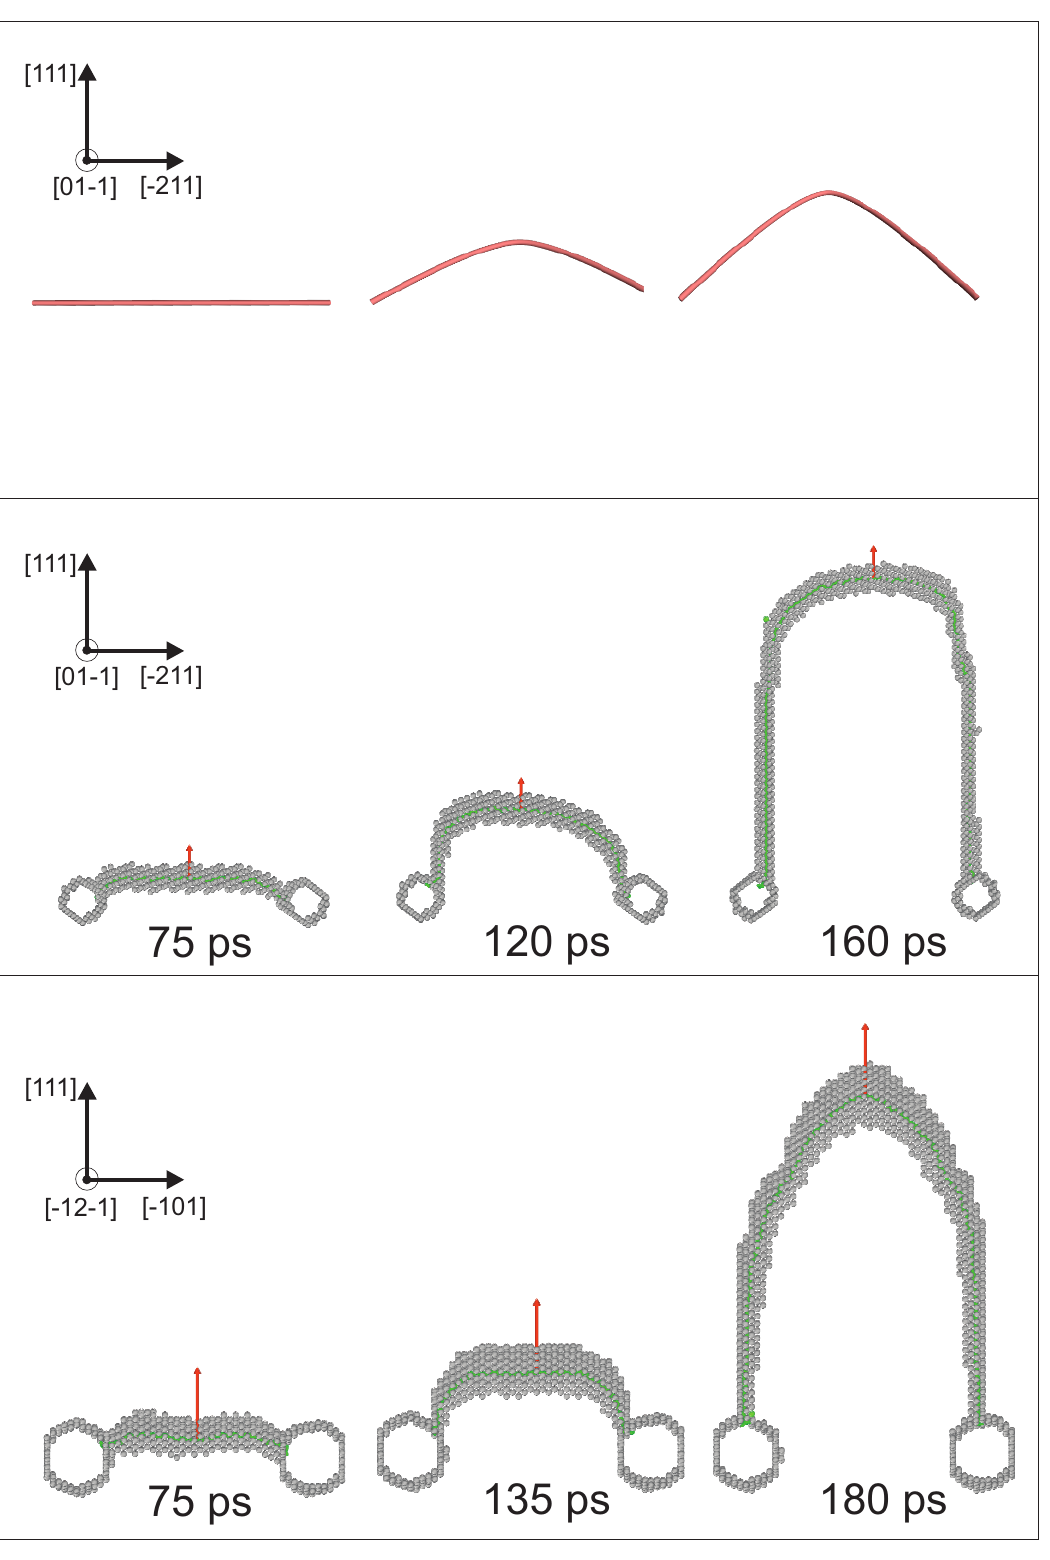
Figure 4. Dislocation mobility of an edge dislocation under shear deformation from the Frank–Read source in iron. Top: DDD simulation; Middle and bottom: MD simulations under shear deformation with a strain rate of 5 × 10 8 s − 1 for two different slip systems. The dislocation is detected by the Dislocation analysis algorithm implemented in OVITO [45]. It is surrounded by disordered atoms in